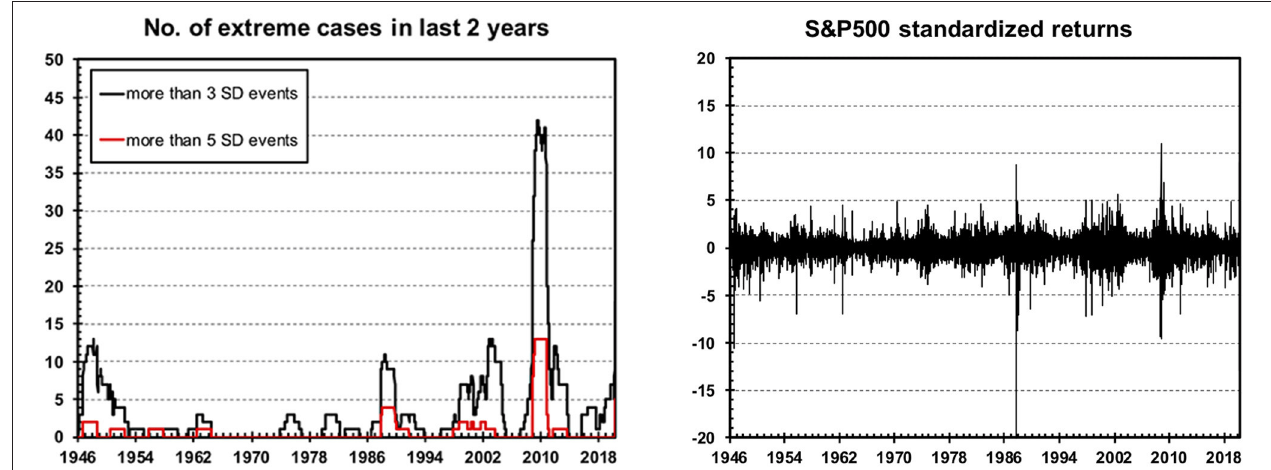
FIGURE 1 | Historical extreme events of the S&P 500. (Left) Logarithmic returns of the S&P 500 between January 1, 1946, and April 17, 2020, demeaned and standardized by the historical mean and standard deviation over the whole examination period. (Right) Number of extreme returns over 3 or 5 standard deviations. Cumulative count on a rolling window of 500 days is